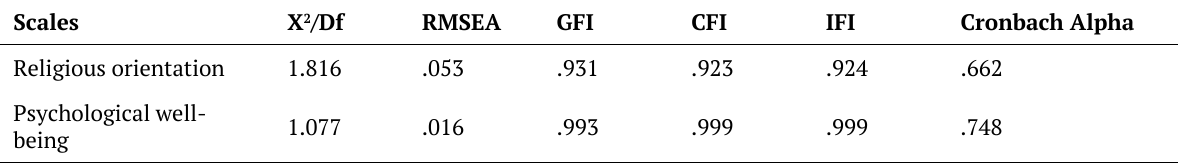
Table 2. Validity and Reliability Results of the Scales